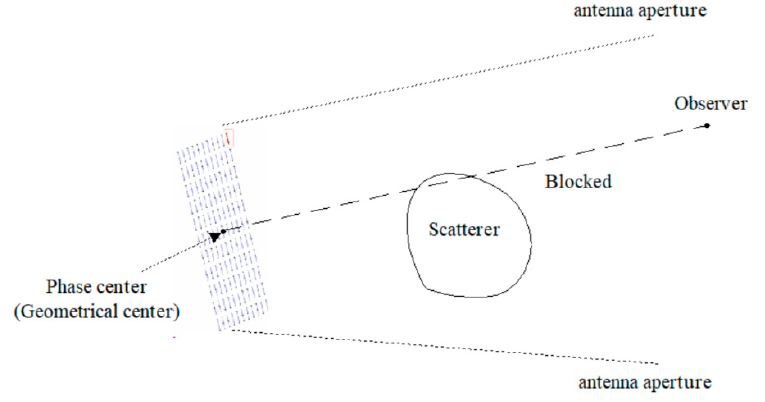
Figure 4. Drawback of the quasihybrid scheme dealing with array antenna.